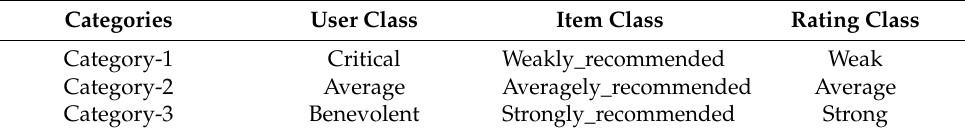
Table 4. User, Item and Rating